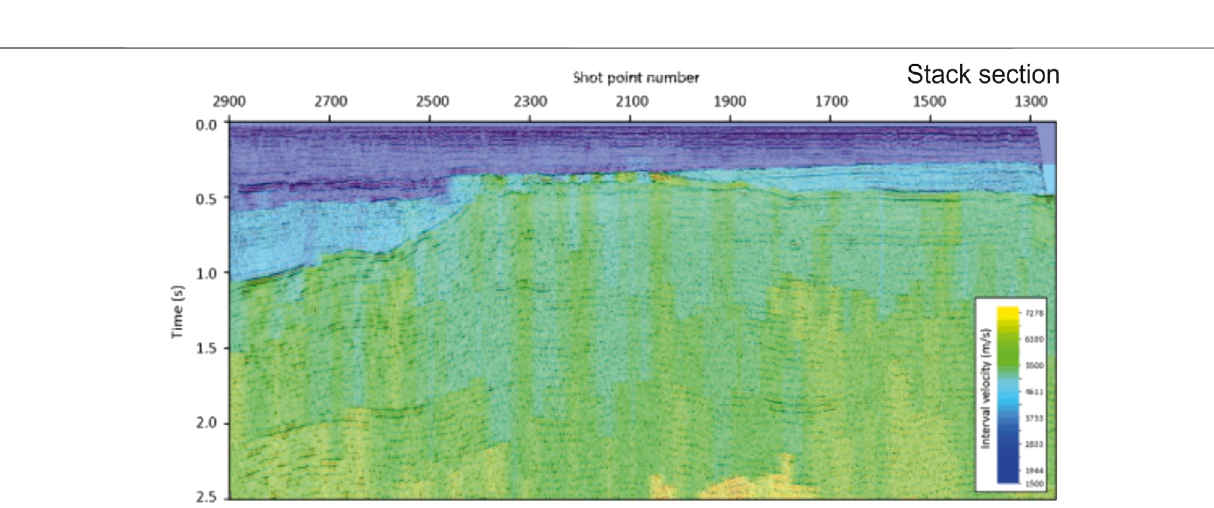
FIGURE 5 | Interval velocities (colored background) derived from stacking velocities, which we used for the spherical divergence correction and the stacked time section (superimposed wiggle plot).